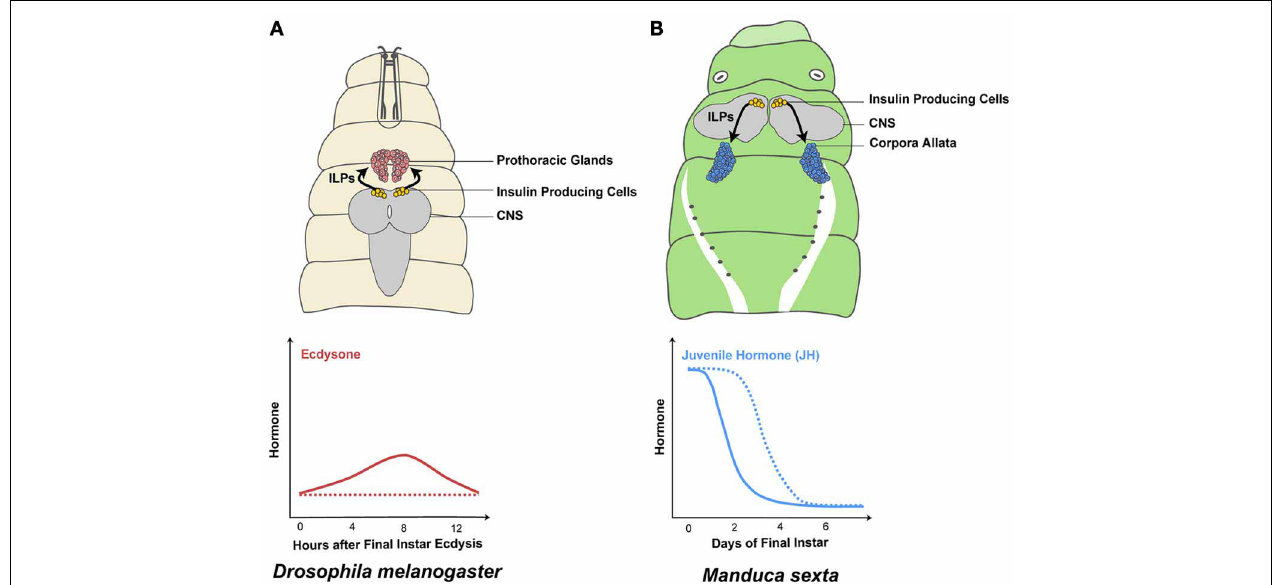
FIGURE 3 | The IIS/TOR pathway regulates metamorphic hormone synthesis. Insulin-like peptide (ILP) secretion by the insulin producing cells in the central nervous system (CNS) depends on nutrition (Masumura et al., 2000; Brogiolo et al., 2001; Ikeya et al., 2002; Colombani et al., 2003). In well-fed final instar Drosophila melanogaster larvae, the prothoracic glands increase ecdysone synthesis in response to high concentrations of ILPs in the hemolymph (solid line in A ) (Caldwell et al., 2005; Colombani et al., 2005; Mirth et al., 2005; Warren et al., 2006). In contrast, when larvae are starved